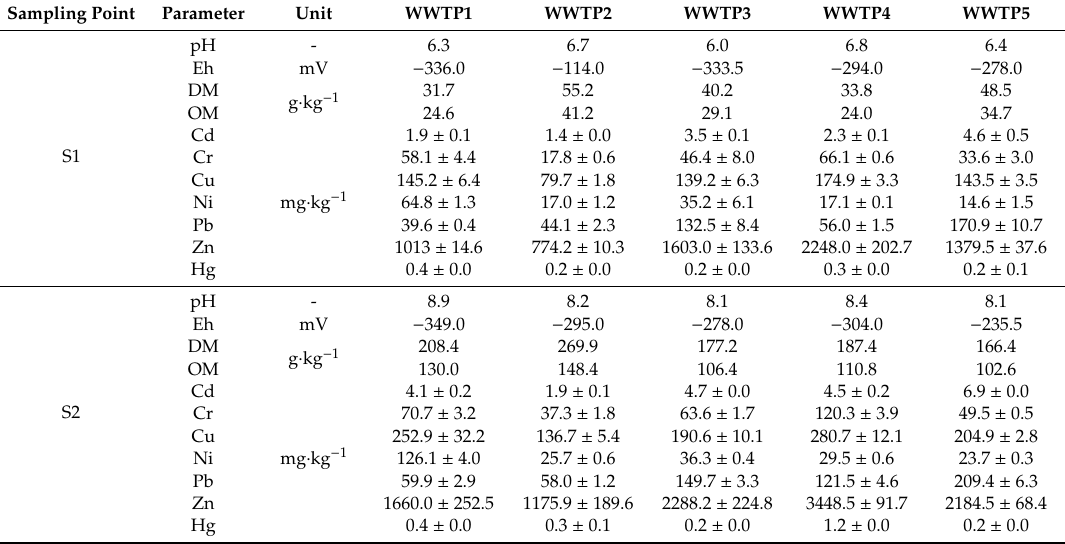
Table 5. Physicochemical characteristics of the sewage sludge